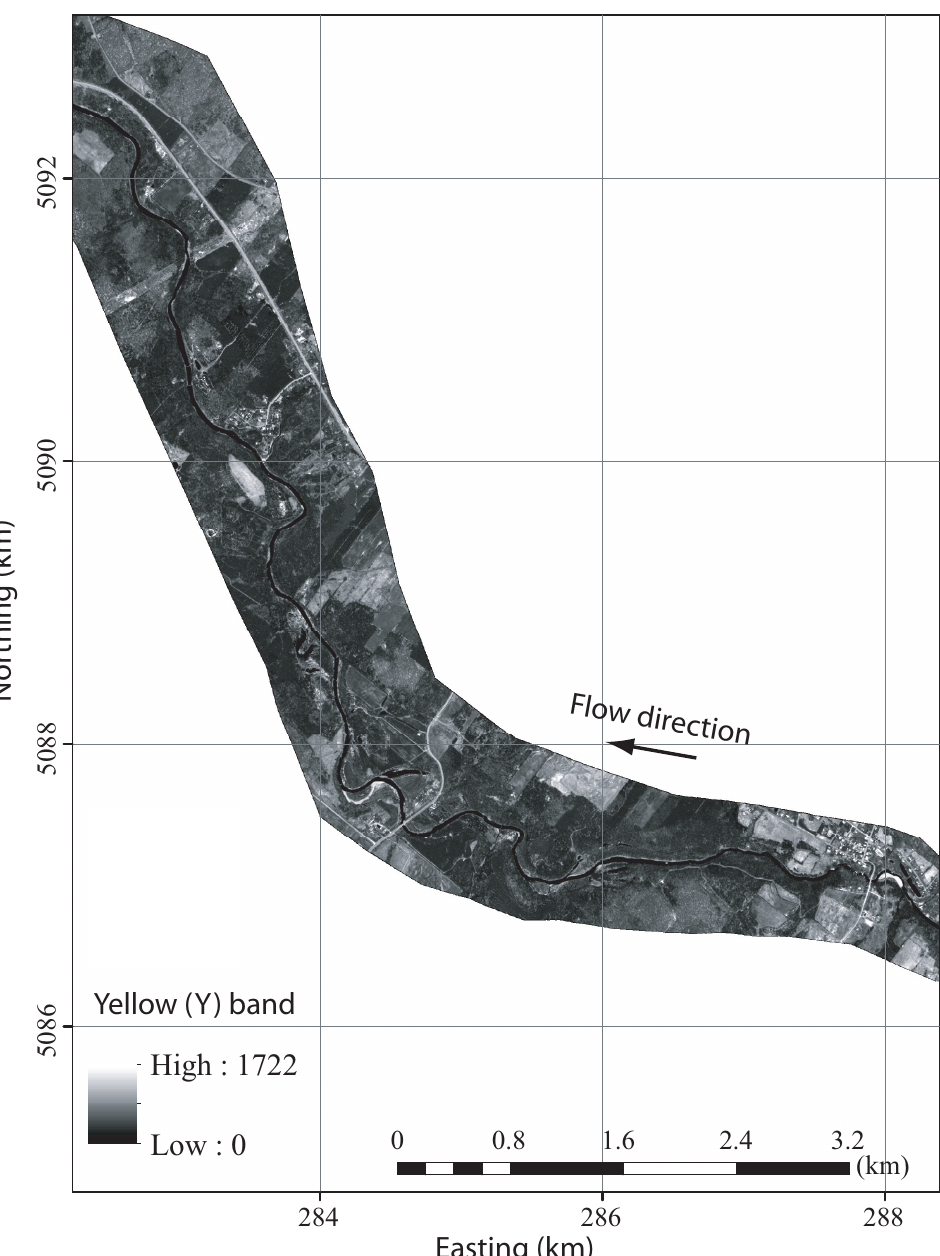
Figure A3. Values of the digital number N (or pixel values) in the yellow (Y) band (Table